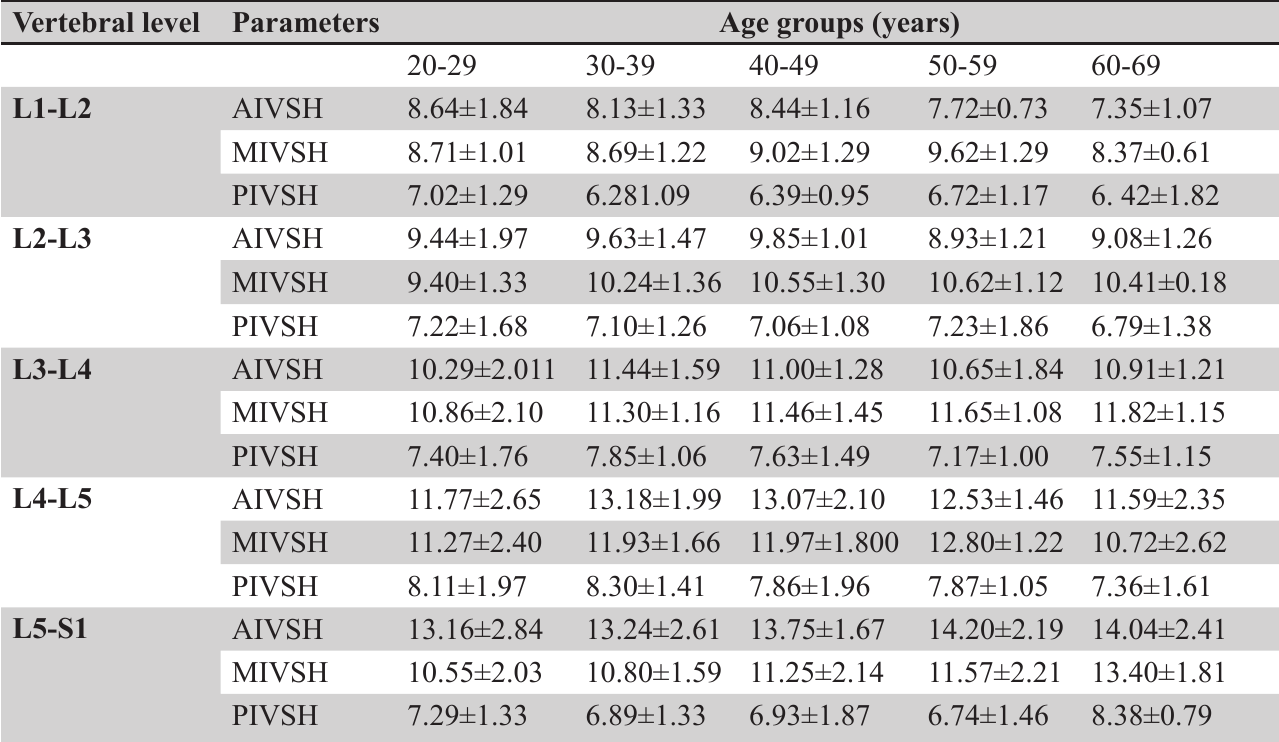
Table 3. Comparison of the mean values of the intervertebral space height among different age groups. Vertebral